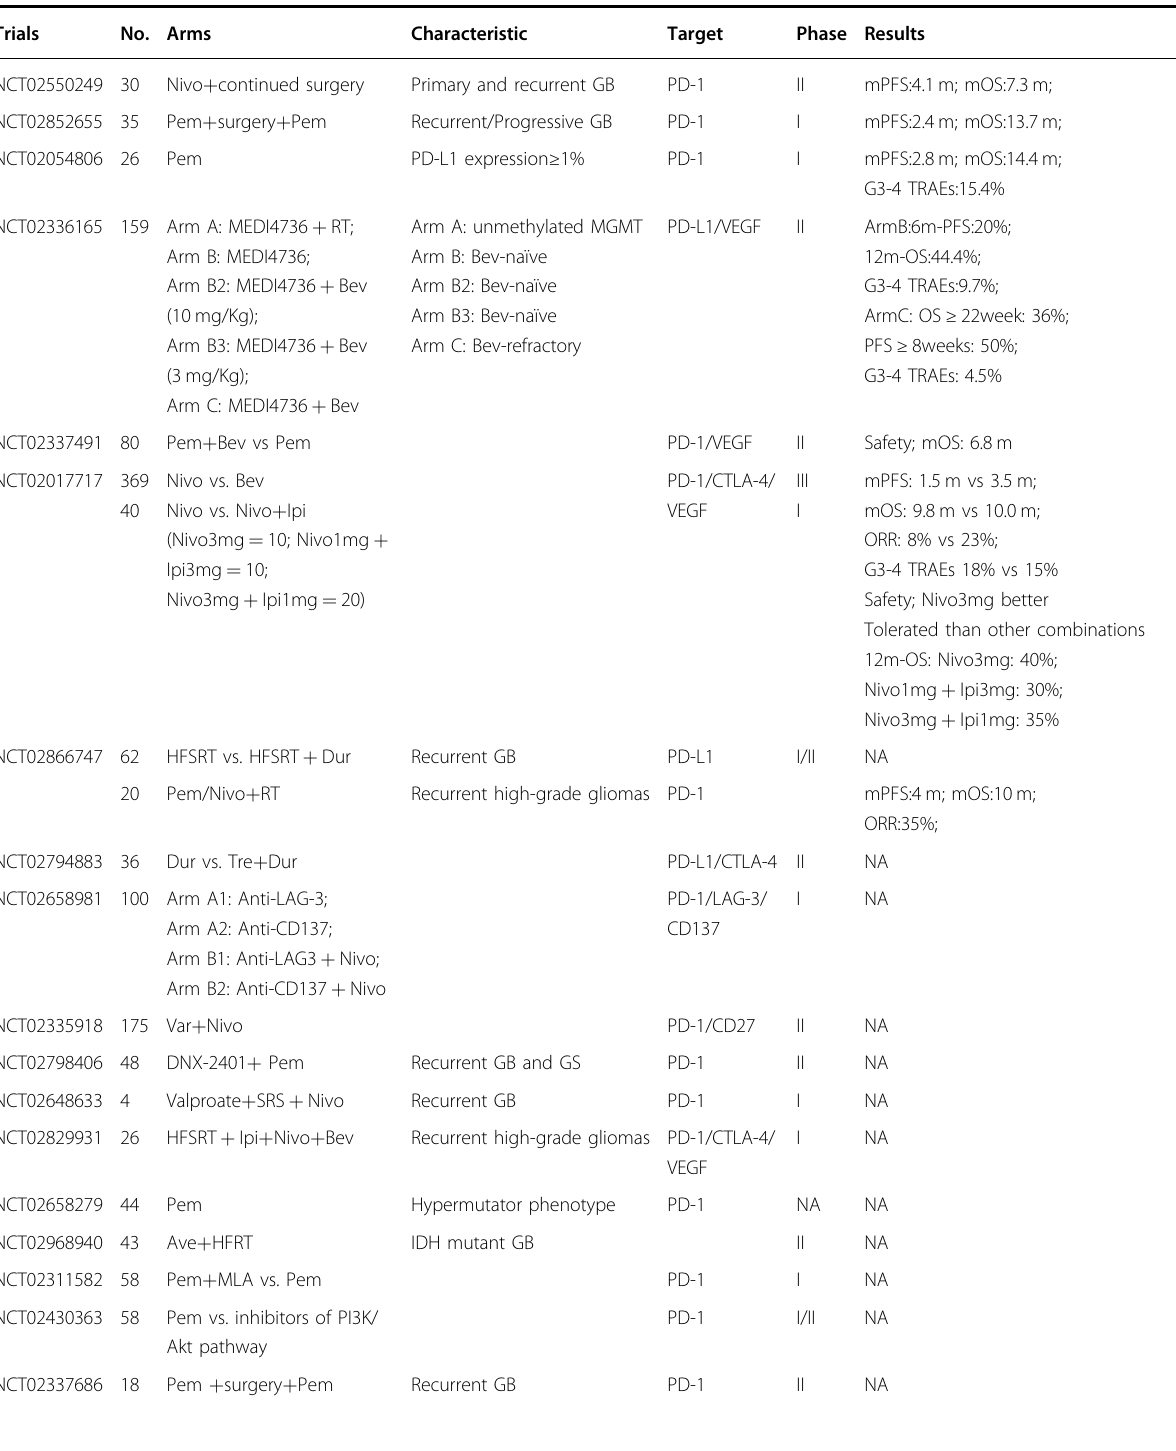
Table 1 Clinical trials of PD-1/PD-L1 checkpoint blockades in recurrent GB.